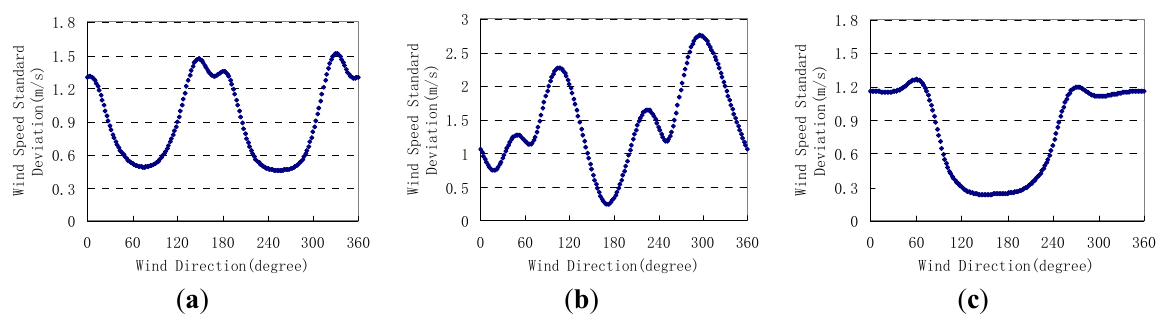
Figure 1. An illustration of wind speed standard deviation curve for a typical wind vector cell (WVC) at: ( a ) outer region (WVC number 2); ( b ) mid region (WVC number 20); and ( c ) nadir region (WVC number